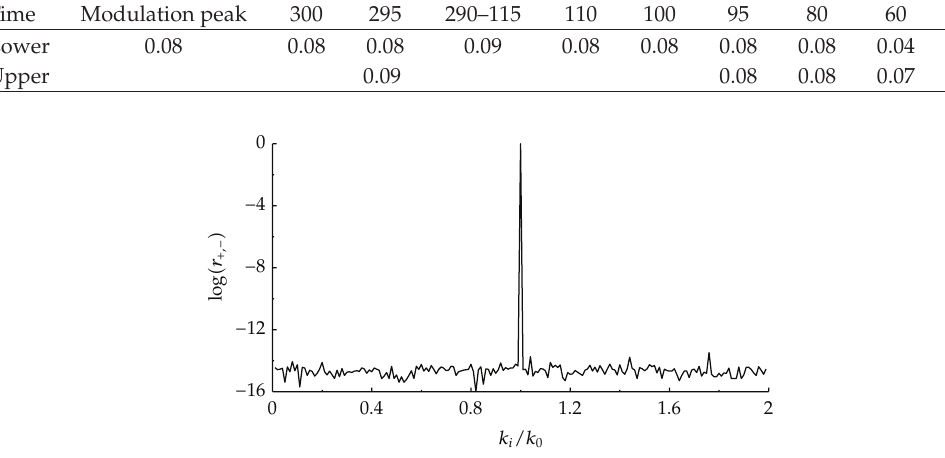
the comparison of lower sidebands. And the latter one is based on the comparison of upper sidebands. Clearly, the “Upper from seeded” matches both the theoretical result of Tulin and the experimental result of